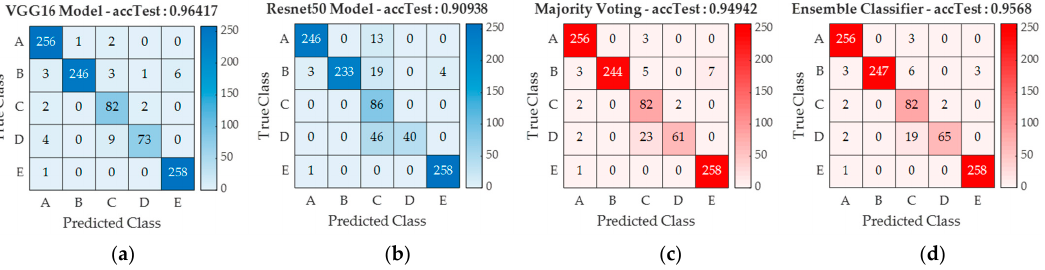
Figure 9. Confusion matrix: ( a ) best, ( b ) weakest, ( c ) voting, and ( d ) ensemble, of raw cut dataset.